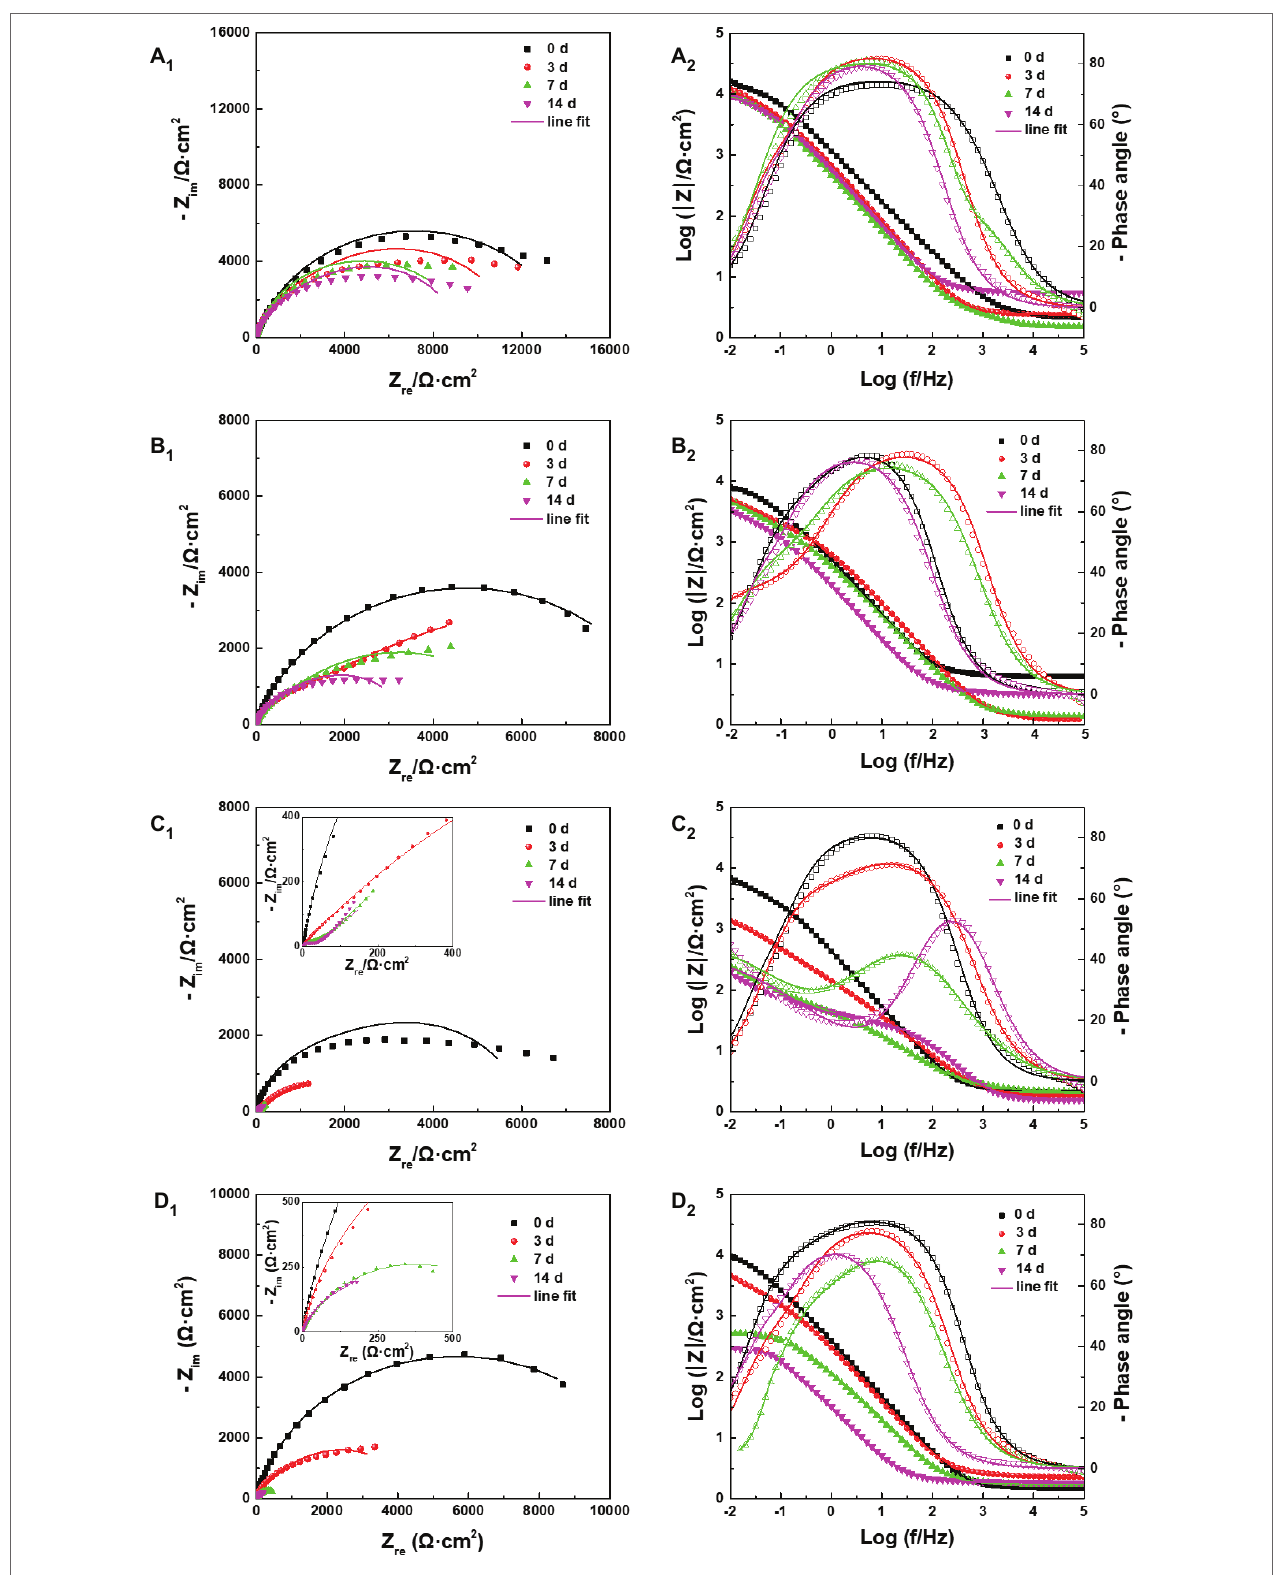
FIGURE 8 | (A 1 –D 1 ) Nyquist plots and (A 2 –D 2 ) Bode plots of the samples after different days of immersion in inoculated media with the DOC of (A) 0.0 ppm, (B) 0.5 ppm, (C) 3.0 ppm, and (D) 5.0